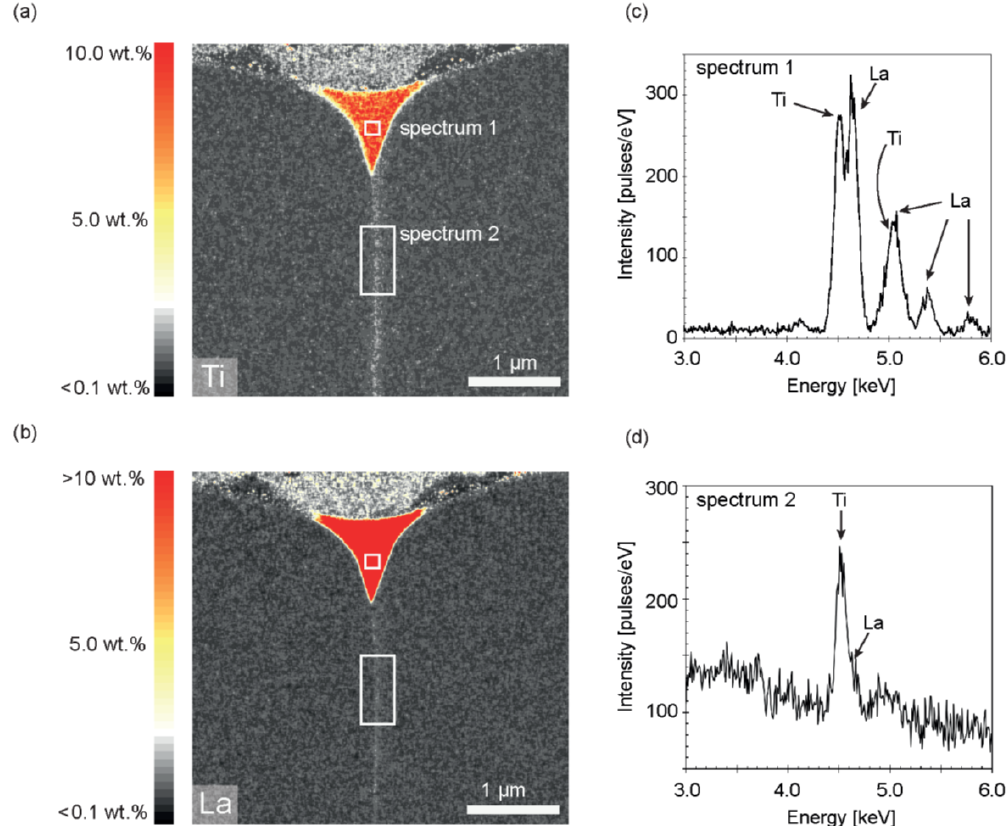
Figure 8. 2D STEM maps of the Ti-containing sample TH_9_3 (1006). The EDX data have been quantified using ESPRIT and a similar quantification method to that given in Sect. 3.2. (a) Ti element concentration map, (b) La element concentration map. The maps are false- color maps: red indicates high concentration and black low concentration of the indicated element. Apparent concentrations in the grain boundary are an artifact of data processing because part of the Ti peak can be misinterpreted as a La signal. (c) EDX spectrum 1 of the thin film within the groove indicated in (a) and (b) showing the Ti K α peak at 4.510keV; the La L α at 4.645keV; the smaller La L β 1, L β 2, and L γ 1 peaks; and the shoulder of the Ti K β peak. (d) EDX spectrum 2 of the grain boundary area indicated in (a) and (b) showing the overlap of the Ti K α and the La L α peak.